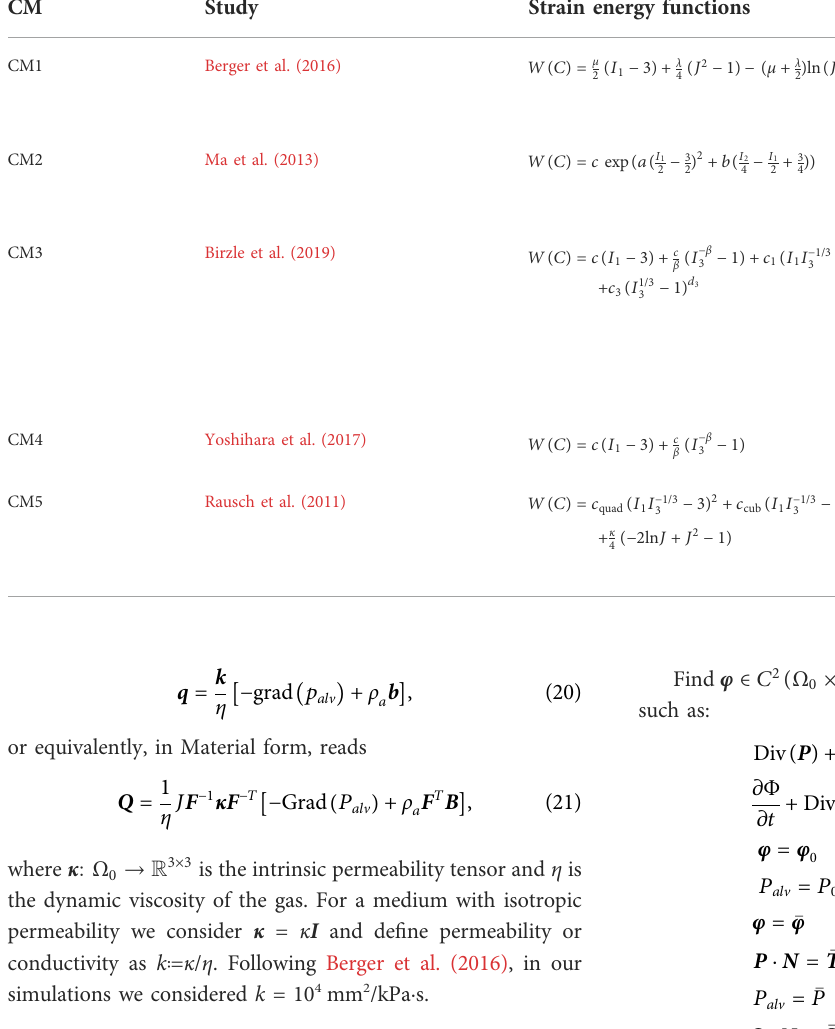
TABLE 1 Constitutive models for lung parenchyma: expressions for strain-energy densities and material parameters. CM Study Strain energy functions